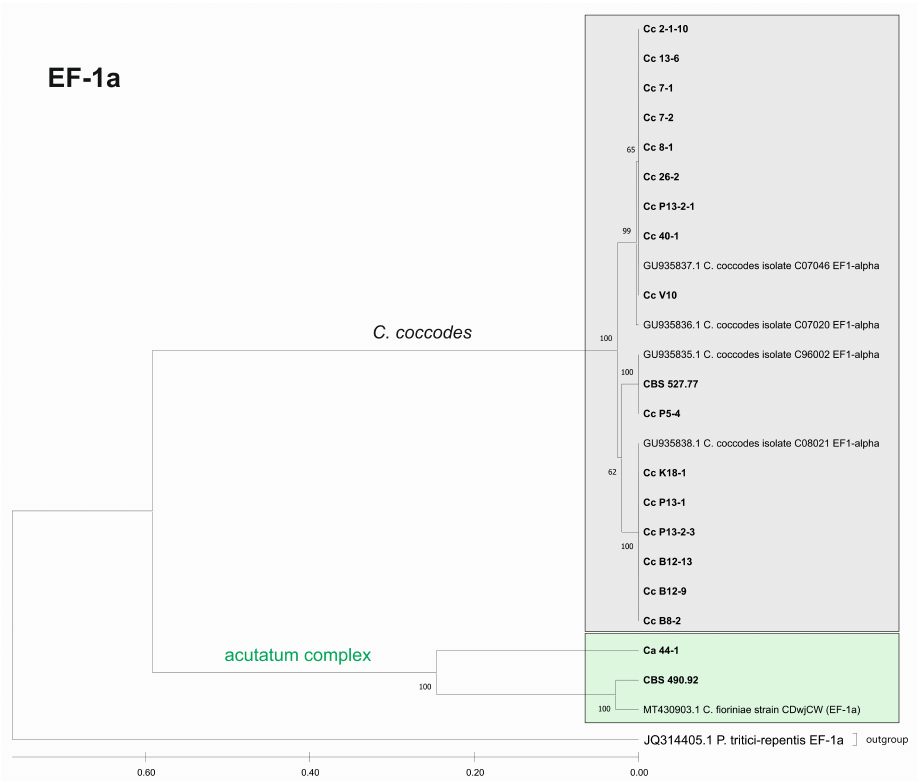
Figure 8. Phylogenetic tree based on the EF-1a barcode. Genetic diversity and taxonomic assignment of studied Colletotrichum isolates against accessions in the NCBI database and assessed by the DNA barcode for the locus translation elongation factor 1-alpha (EF-1a). The Colletotrichum clades coccodes and acutatum are depicted by grey and green boxes, respectively. The trees were constructed in MEGA11 using the UPGMA clustering method and the Kimura 2-parameter model. The percentage of replicate trees in which the associated taxa clustered together in the bootstrap test (500 replicates) is shown next to the branches. The tree is drawn to scale, with branch lengths in the same units as those of the evolutionary distances used to infer the phylogenetic tree. All ambiguous positions were removed for each sequence pair (pairwise deletion option). Sequences derived from the NCBI are shown with their accession number and organism